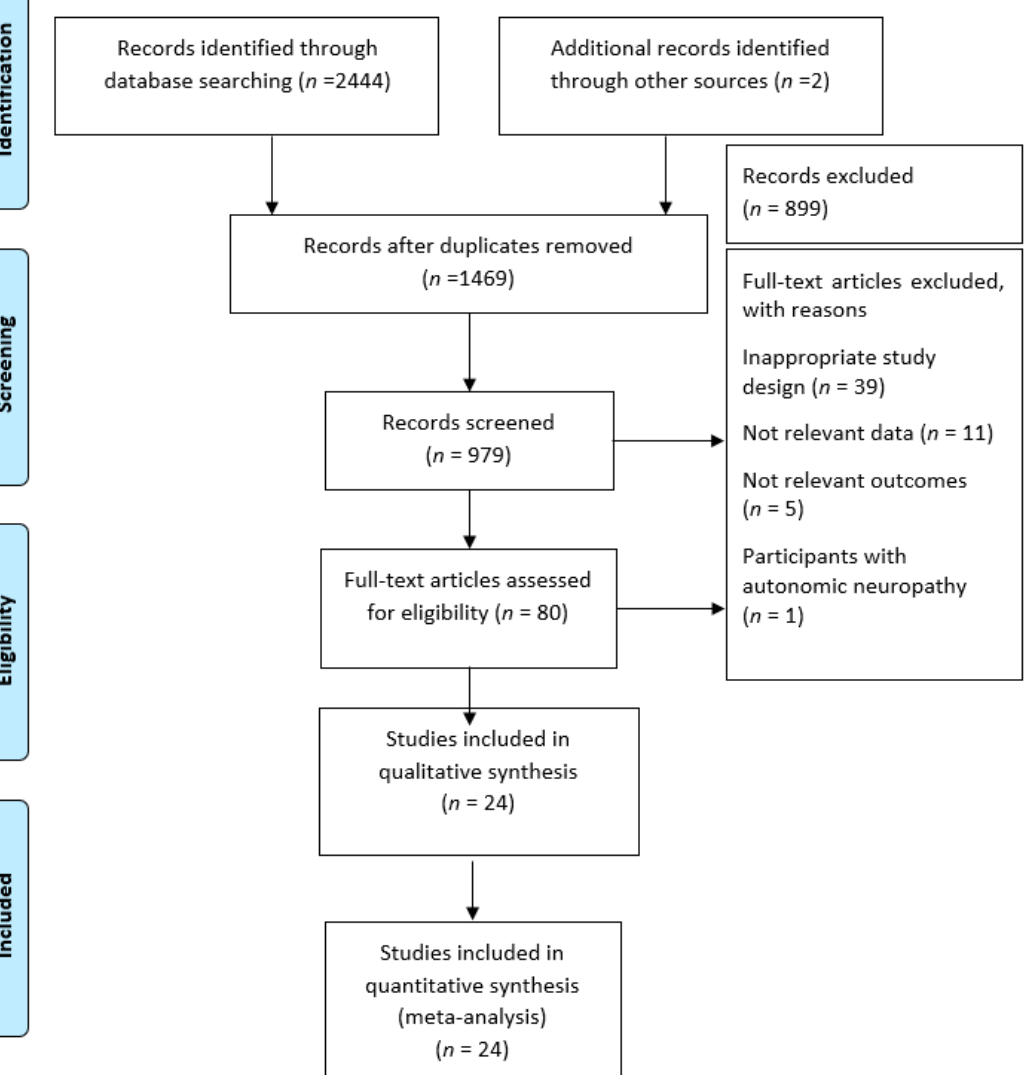
Figure 1. Study flow diagram in line with Preferred Reporting Items for Systematic Reviews and Meta-Analyses (PRISMA) recommendations.